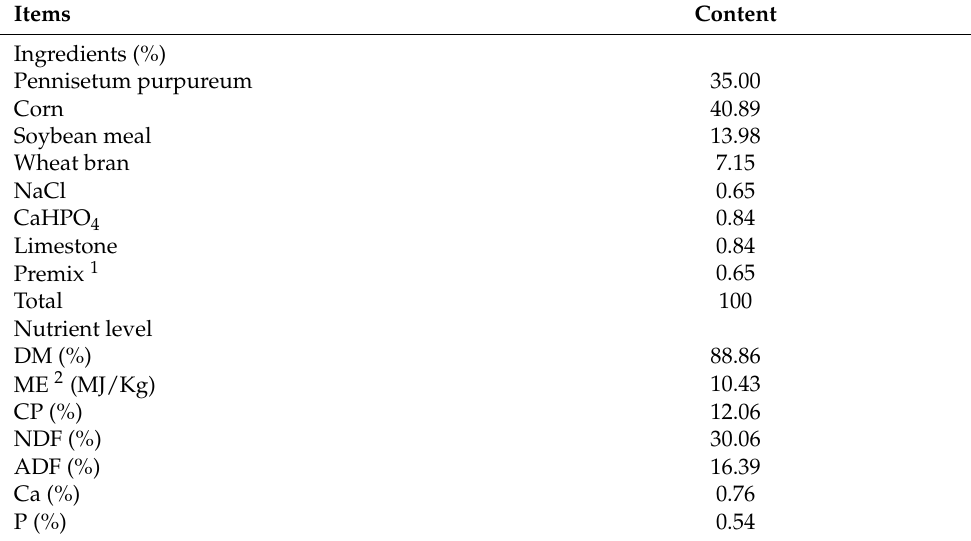
Table 1. The composition and level of basal diet (air-dry